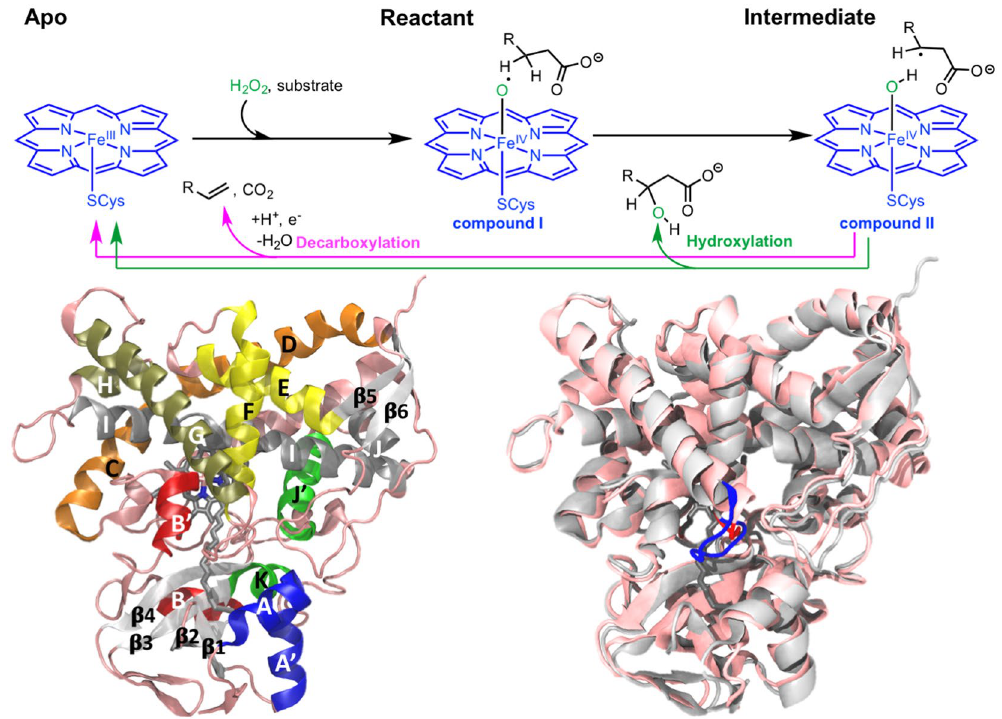
Figure 1. (Top) The reaction mechanism: The first step of H-abstraction by compound I is common to both hydroxylases and decarboxylases followed by catalytic bifurcation at the intermediate state with the substrate radical and compound II. (Bottom: Left) Canonical P450 structural fold in OleT JE with α -helices colored as follows A,A’-blue; B,B’-red; C,D-orange; E,F-yellow; G,H-tan; I,J-gray; J’,K-green. The β -sheets are colored in white and the loops in pink. (Bottom: Right) Structural comparison between OleT JE (silver) and P450 BS β (white). The differences in the F-G loop are highlighted with the longer OleT JE loop shown in Blue and the shorter loop in P450 BS β shown in